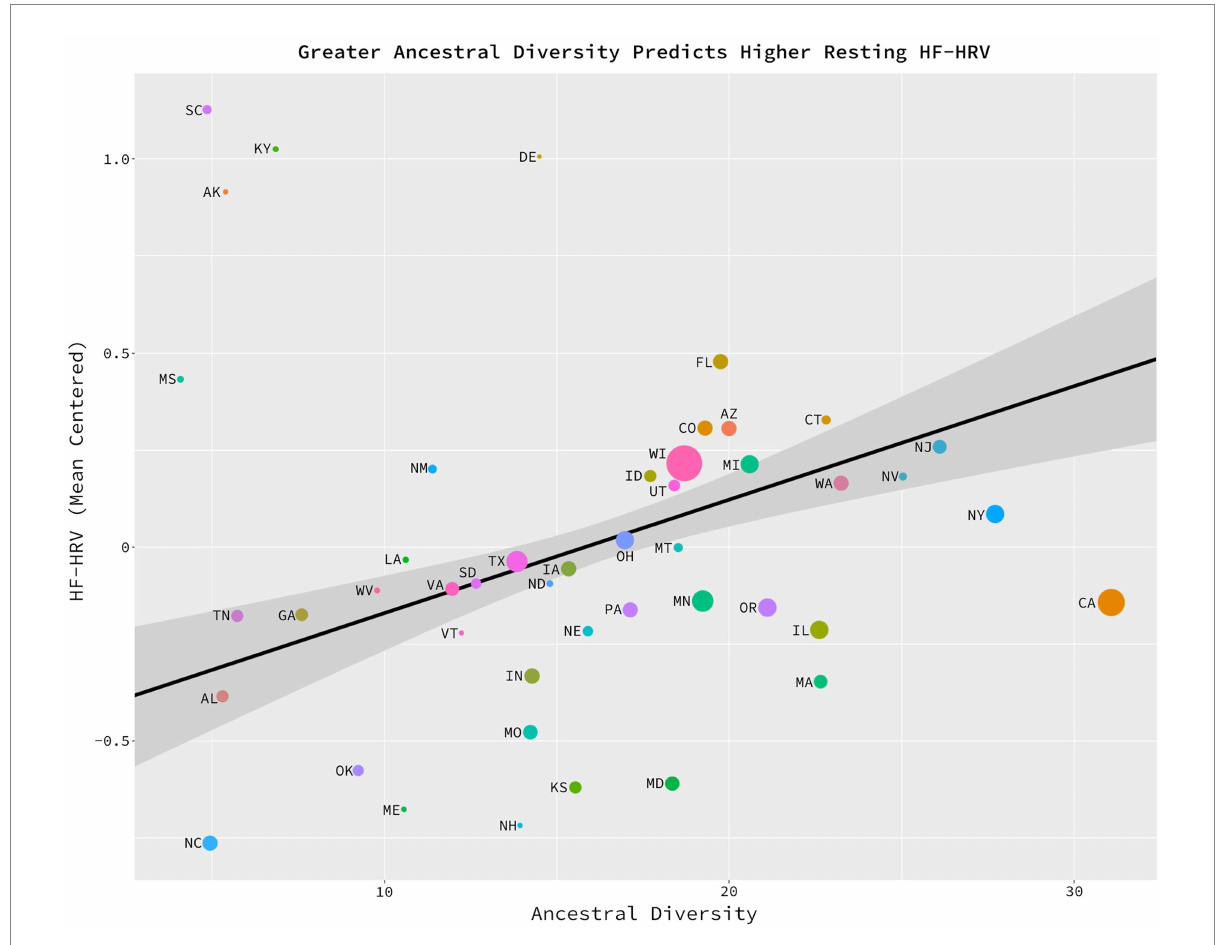
FIGURE 2 Greater ancestral diversity related to higher HF-HRV. Significant positive relationship between ancestral diversity and the average, baseline HF-HRV of the states’ citizens, b = 0.029, sd_b = 0.435, t (42) = 2.291, p = 0.027, η p2 = 0.11, CILO = 0.003, CIHI = 0.055. On the x axis, the average number of foreign countries which have contributed to at least 0.5% of a state’s population since 1850. On the y axis, a mean-centered average of baseline, HF-HRV residualized on health, age, and sex. This figure is generated from a data set consisting of 46 data points. Each data point represents one of the U.S. states (excluding Alaska, Hawaii, Rhode Island, and Wyoming). The size of each data point represents the number of observations per state from which the HF-HRV scores were